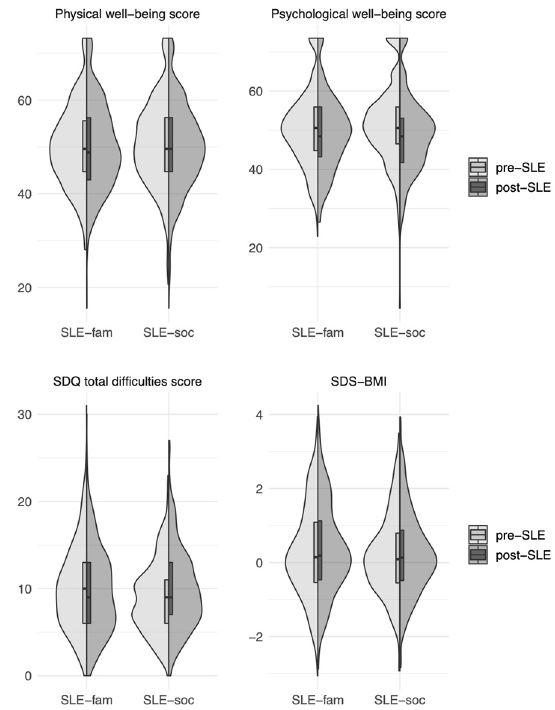
Figure 2. Health parameters before and after an SLE. Distribution of all considered health parameters before and after an SLE had occurred. Score ranges: well-being scores (t-value): 0–100; SDQ total difficulties score: 0–10; BMI-SDS: standard deviation compared to a reference sample. Shaded areas show split violin plots of the density function with inserted boxplots indicating the median and the first and third quartile. pre-SLE = before SLE; post-SLE = after SLE.